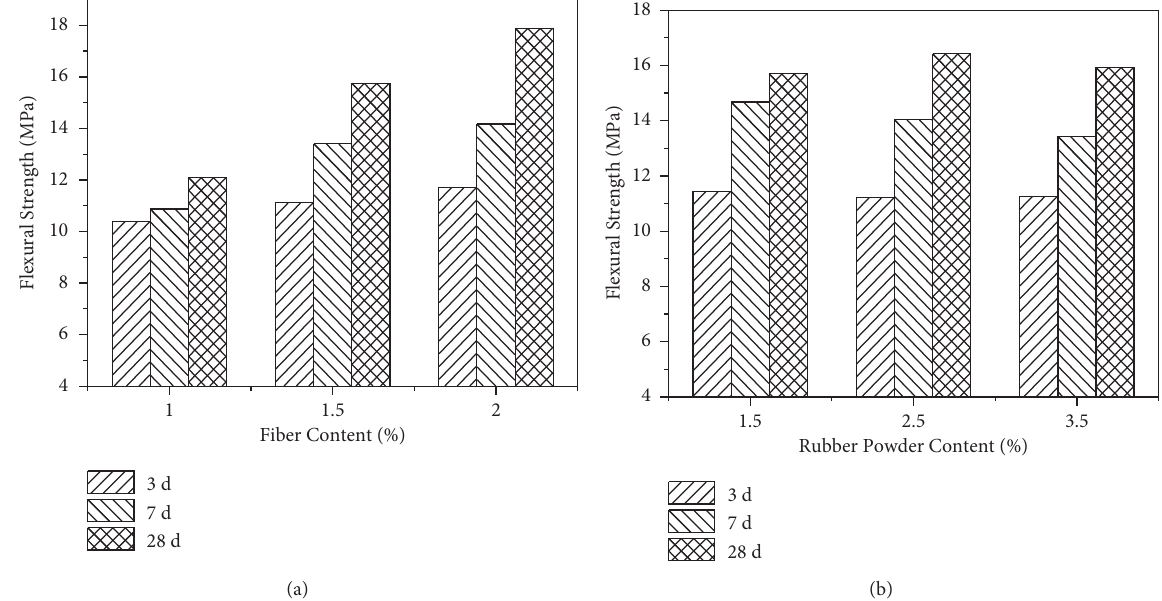
Figure 7: Flexural strength of mortars with different fiber and rubber powder contents when RH � 70%. (a) Fiber content. (b) Rubber powder